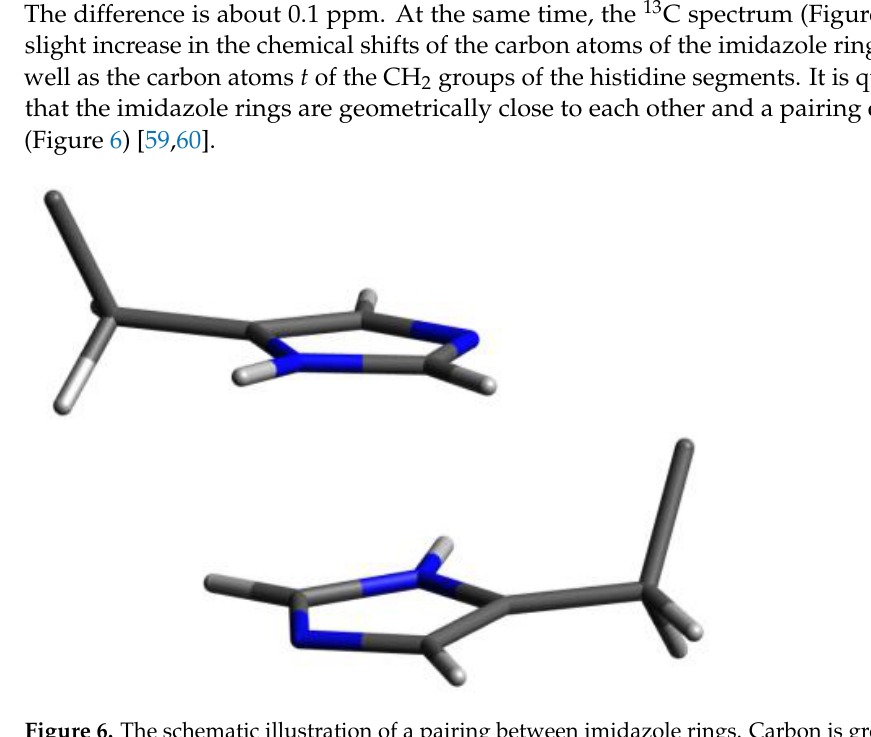
Figure 6. The schematic illustration of a pairing between imidazole rings. Carbon is grey; nitrogen is blue; hydrogen is